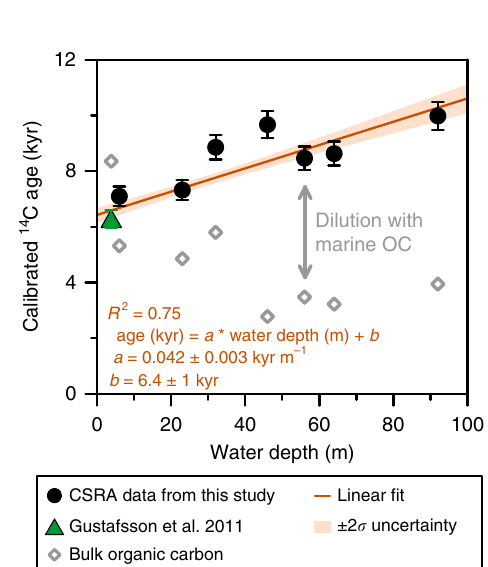
Fig. 2 Calibrated radiocarbon ages of terrigenous long-chain n -fatty acids and bulk organic carbon vs. water depth. All fi lled symbols refer to compound- speci fi c radiocarbon ages of long-chain n -fatty acids (LCFAs) with black circles: data from this study, green upward-pointing triangle: data point from a previous study 16 , and error bars representing±1 σ uncertainties. The linear fi t to all biomarker ages (orange straight line, shaded area refers to±2 σ uncertainties of the fi t, determined by Monte Carlo simulations) is used to derive the transport time of sedimentary terrOC across the Laptev Sea shelf: Transport time kyr